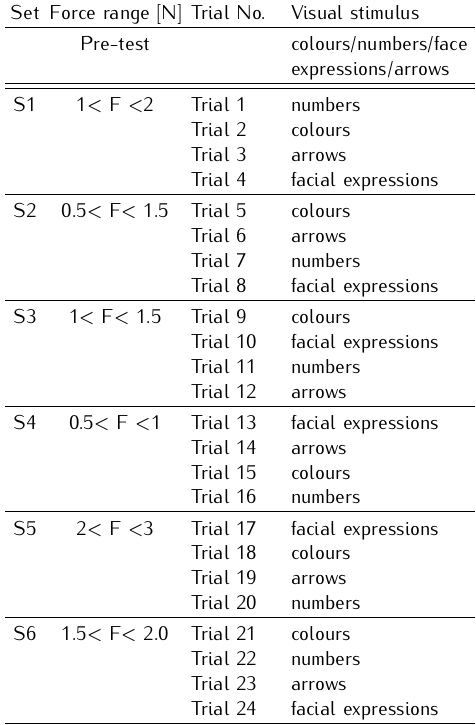
Table 3. Arrangement of the